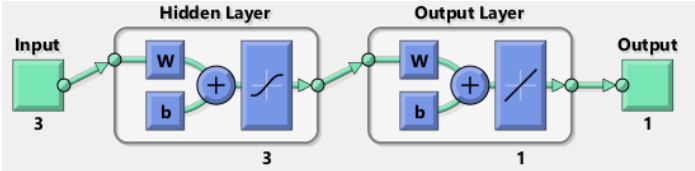
Figure 2. Neural network model including 3 hidden layers. 3 inputs are DTC, GR, RHOZ, and the single output is DTS.